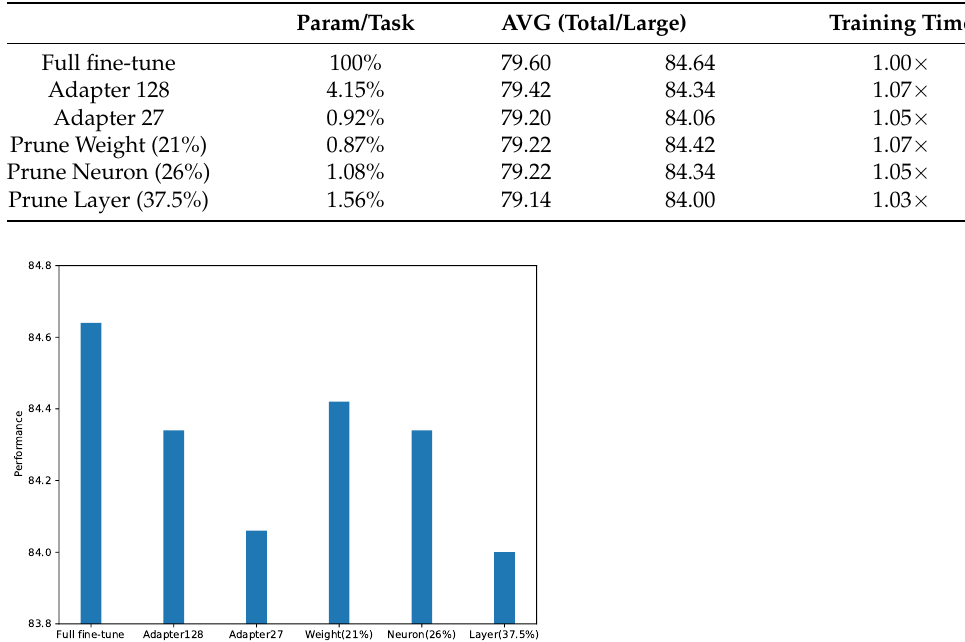
Figure 4. Winning ticket of different pruning schemes on GLUE test, with average results on large datasets in GLUE (SST-2, QQP, MNLI, MNLI mm ,